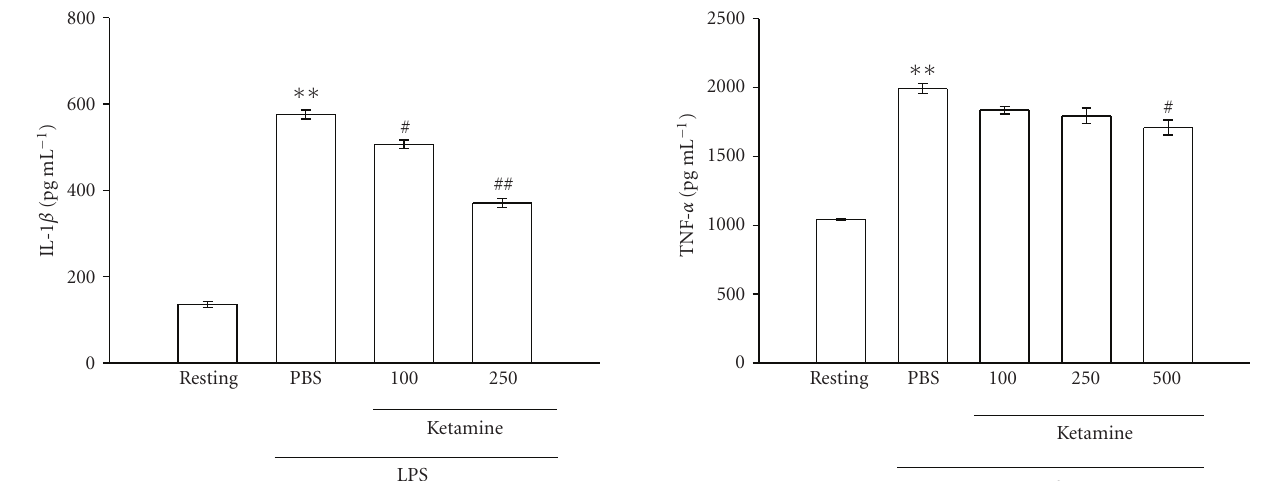
Figure 4: E ff ect of ketamine on tumor necrosis factor (TNF)- α pro- duction in lipopolysaccharide (LPS)-activated microglia. Microglia (5 × 10 5 cells mL − 1 ) were treated with various concentrations of ketamine (100, 250, and 500 μ M) or an isovolumetric PBS bu ff er for 30 minutes, followed by the addition of LPS (100ng mL − 1 ) for 3 hours. Cell-free supernatants were assayed for TNF- α production as described in Section 2. Data are presented as the means ± S.E.M. ( n = 3). ∗∗ P < . 01, compared to the resting group; # P < .